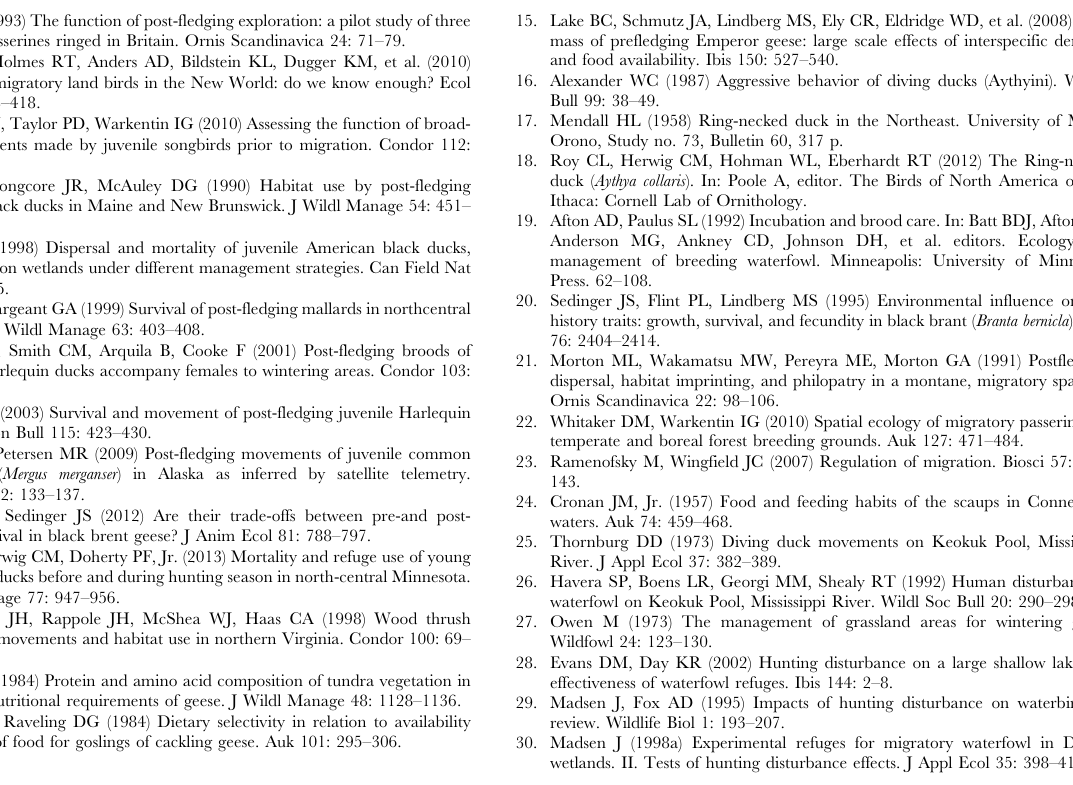
same week ( n = 26 out of a total of 1802 observations), we summed the displacements prior to taking the among-bird average. Figure S5 Average weekly fall distances from brood- rearing lakes calculated along north-south (N–S) and east–west (E–W) axes by sex for ring-necked ducks. Data are pooled from 2007–2010. Distances were calculated using UTM coordinates associated with the bird’s current location, ( X t , Y t ). and the centroid of the bird’s brood-rearing lake, ( X 0 , Y 0 ) in north-central Minnesota. Specifically, the E–W lines depict weekly ffiffiffiffiffiffiffiffiffiffiffiffiffiffiffiffiffiffiffiffiffi q ( X i { X 0 ) 2 among-bird means of: , where i indexes successive bird locations. Similarly, the N–S lines depict weekly among-bird q ffiffiffiffiffiffiffiffiffiffiffiffiffiffiffiffiffiffiffiffiffi ( Y i { Y 0 ) 2 . means of: